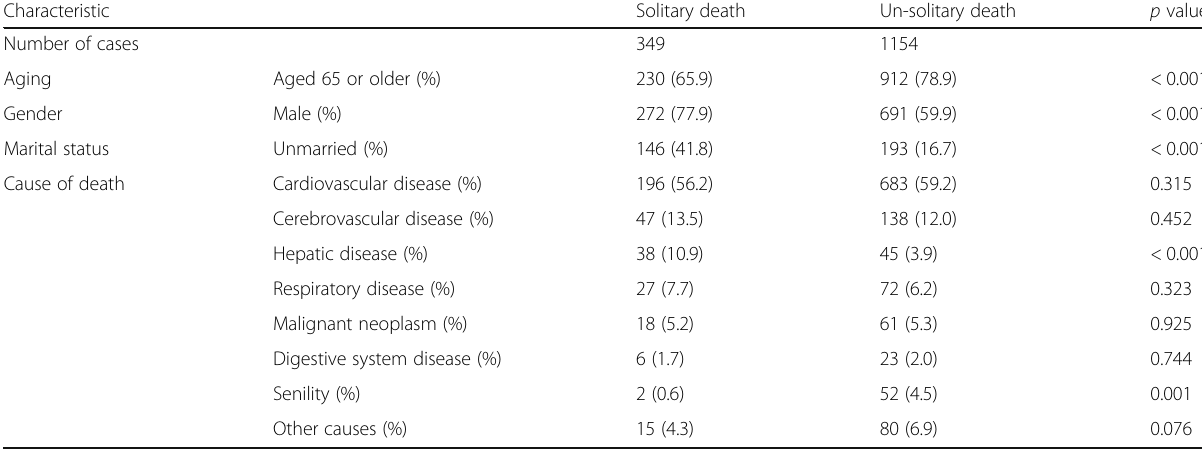
Table 1 Characteristics of study subjects